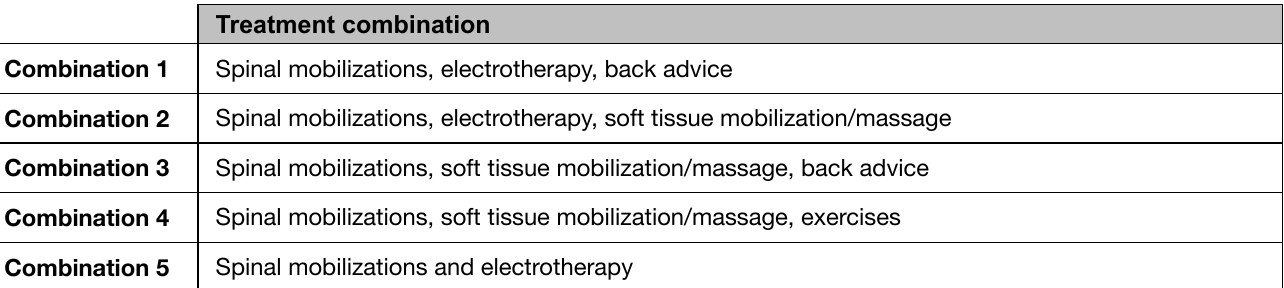
Table 8: Five most common combinations of modalities used in first treatment session Treatment